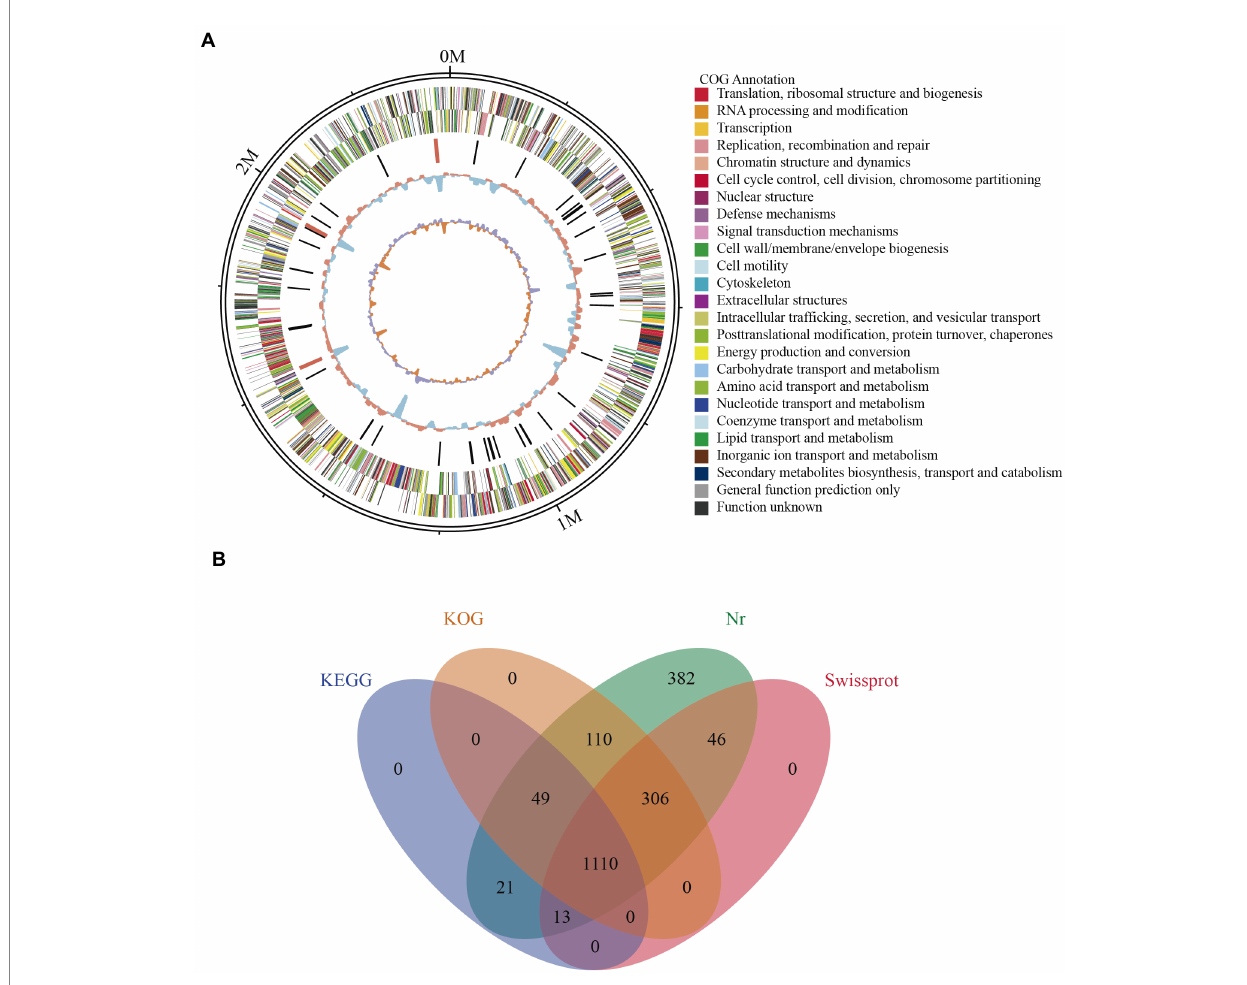
FIGURE 4 Genome assembly and annotation of K. kristinae_LC . (A) Circular representation of the genome of K. kristinae_LC . (B) Venn diagram showing shared and distinct orthologous genes for protein functions based on different